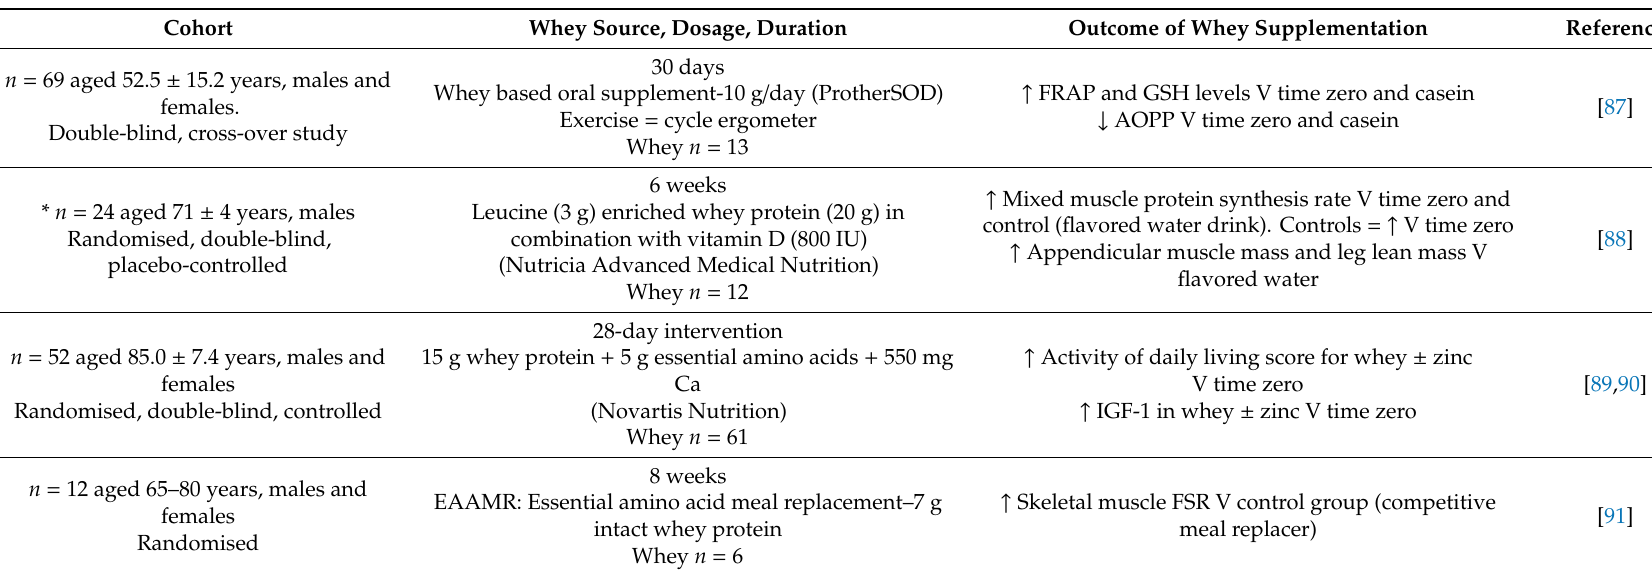
Table 5. Older adult intervention with whey protein supplementation but no exercise. IGF-1: Insulin growth factor 1; EAAMR: Essential amino acid meal replacement; FSR: fractional synthesis rate. * power calculation to determine number of subjects was performed. Cohort n = 69 aged 52.5 ± 15.2 years, males and